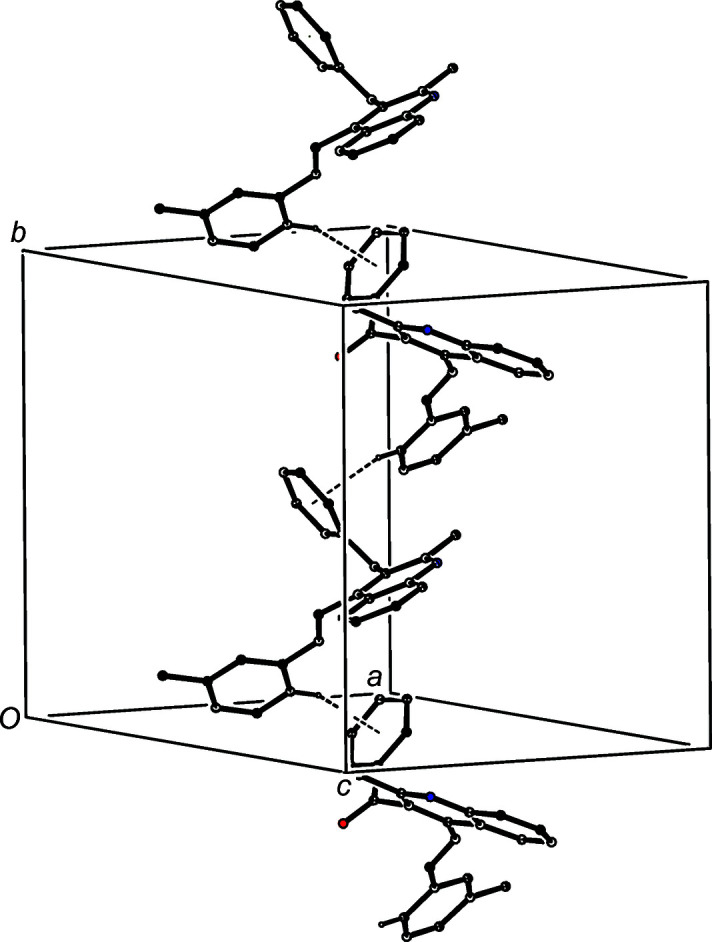
Part of the crystal structure of com­pound (VII), showing the formation of a chain built from C—H⋯π(arene) hydrogen bonds, drawn as dashed lines, running parallel to the [010] direction. For the sake of clarity, H atoms which are not involved in the motif shown have been omitted.